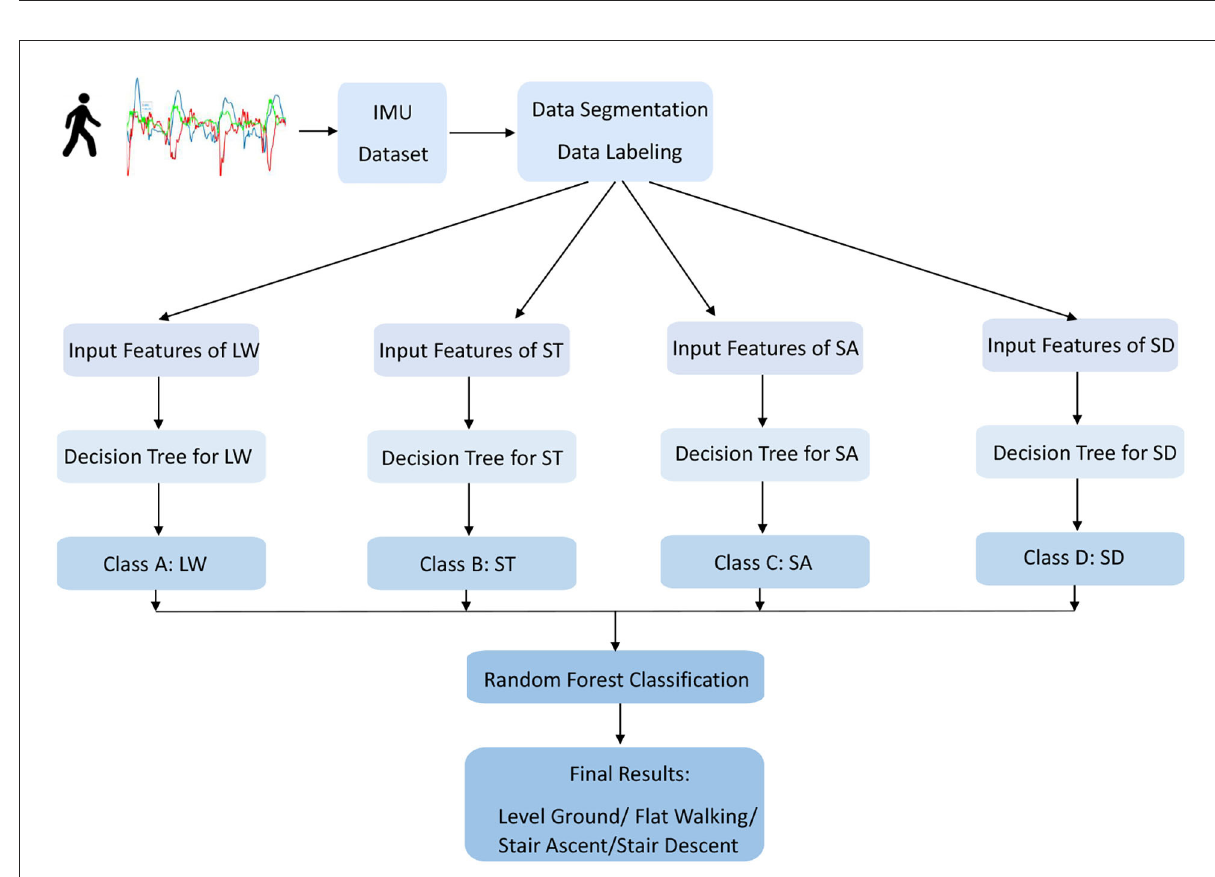
a three-layer structure: input layer, hidden layer, and output layer. The first layer is an input layer that consists of six input signals in a time series sequence. The second layer is a hidden